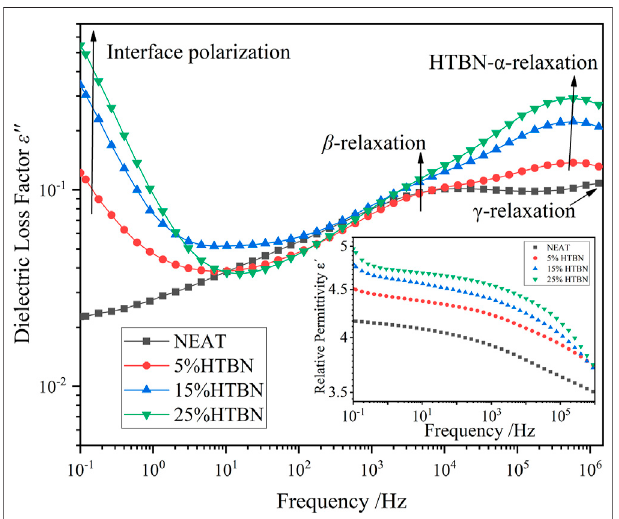
FIGURE 6 | Temperature dependence of the imaginary part of the complex dielectric constant of different rubber contents at high frequency.